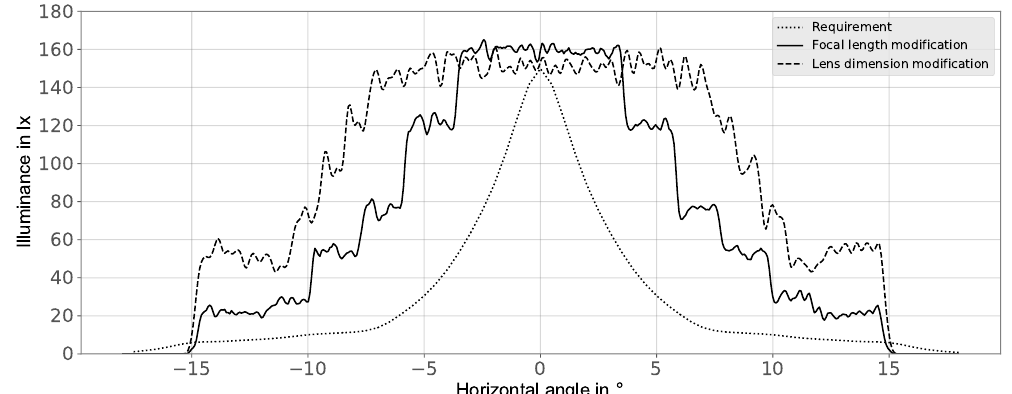
Figure 13. A comparison of the quantified distributions with the requirements for headlamp high beams in